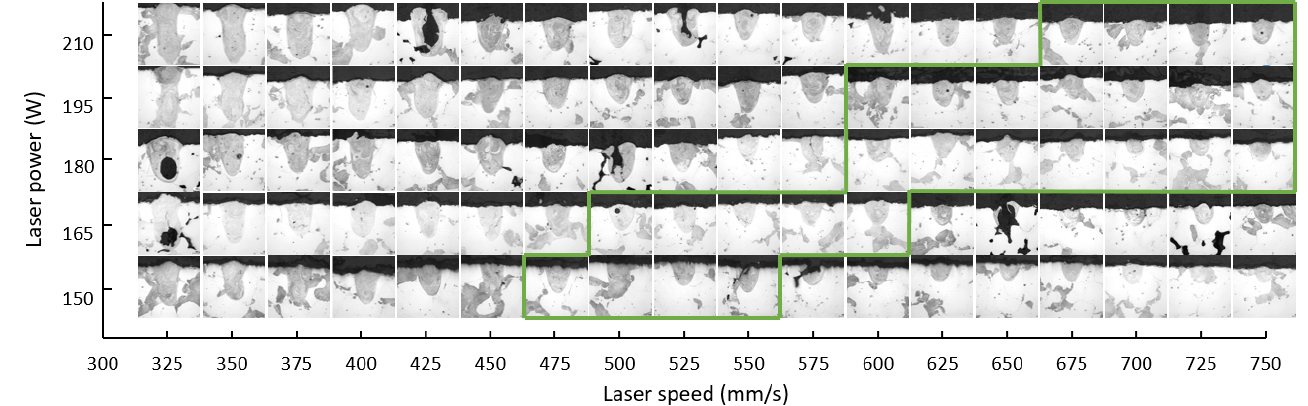
Figure 5. Metallographic images of single tracks for the entire experimental area. Green border represents parameters used for follow-up testing.